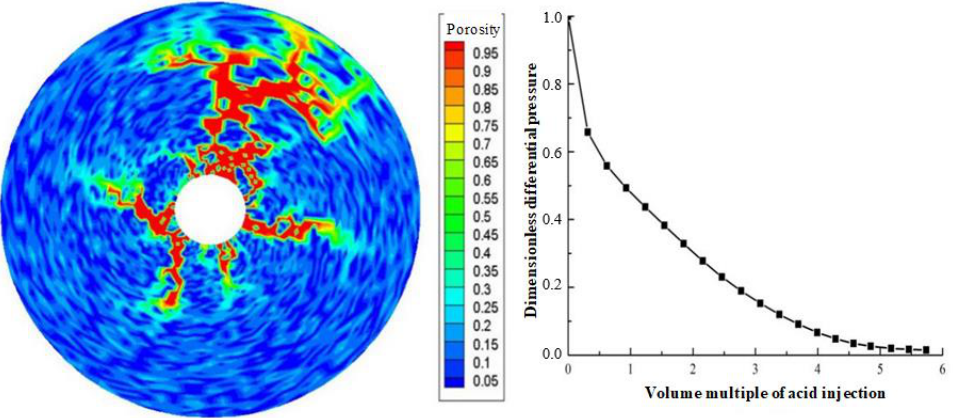
Figure 7. Change of dissolution form and differential pressure with gelling acid injection (gelling acid injection speed 6.5 cm/min).